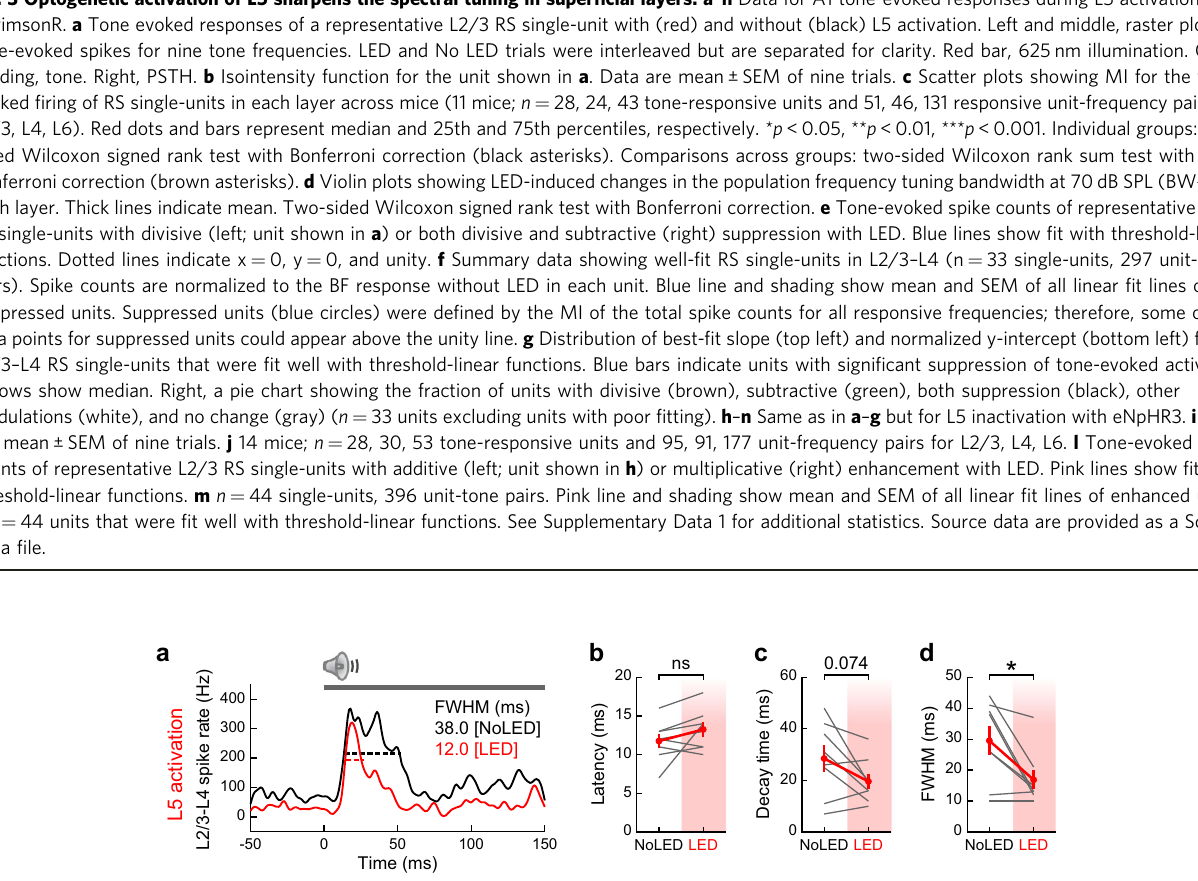
Fig. 4 Photoactivation of L5 sharpens spike timing in super fi cial layers. a PSTH of tone-evoked multi-unit activity combining L2/3 – L4 spikes with (red) or without (black) L5 activation in a representative mouse. Black and red bars show full width at half maximum (FWHM). Gray bar, tone stimulation. b – d Summary data showing b onset latency (time to 20% maximum), c decay time (time from 100% to 30% maximum), and d FWHM, for all mice ( n = 8 mice; latency, p = 0.13; decay, p = 0.074; FWHM, * p = 0.016; two-sided paired t -test). Data are mean ± SEM. Frequencies with signi fi cant responses in either LED or No LED conditions were included in multi-unit spikes. Only multi-unit data with signi fi cant responses in both LED and No LED conditions were included in kinetics analyses. These necessary selection criteria biased FWHM towards larger values in L5 activation experiments since mice with small responses in No LED trials tended to be excluded due to the loss of responsiveness in LED trials. e – h Same as in a – d but for L5 inactivation with eNpHR3 ( n = 9 mice; latency, p = 0.10; decay, ** p = 0.0027; FWHM, * p = 0.020; two-sided paired t -test). Data are mean ± SEM. See Supplementary Data 1 for additional statistics. Source data are provided as a Source Data fi